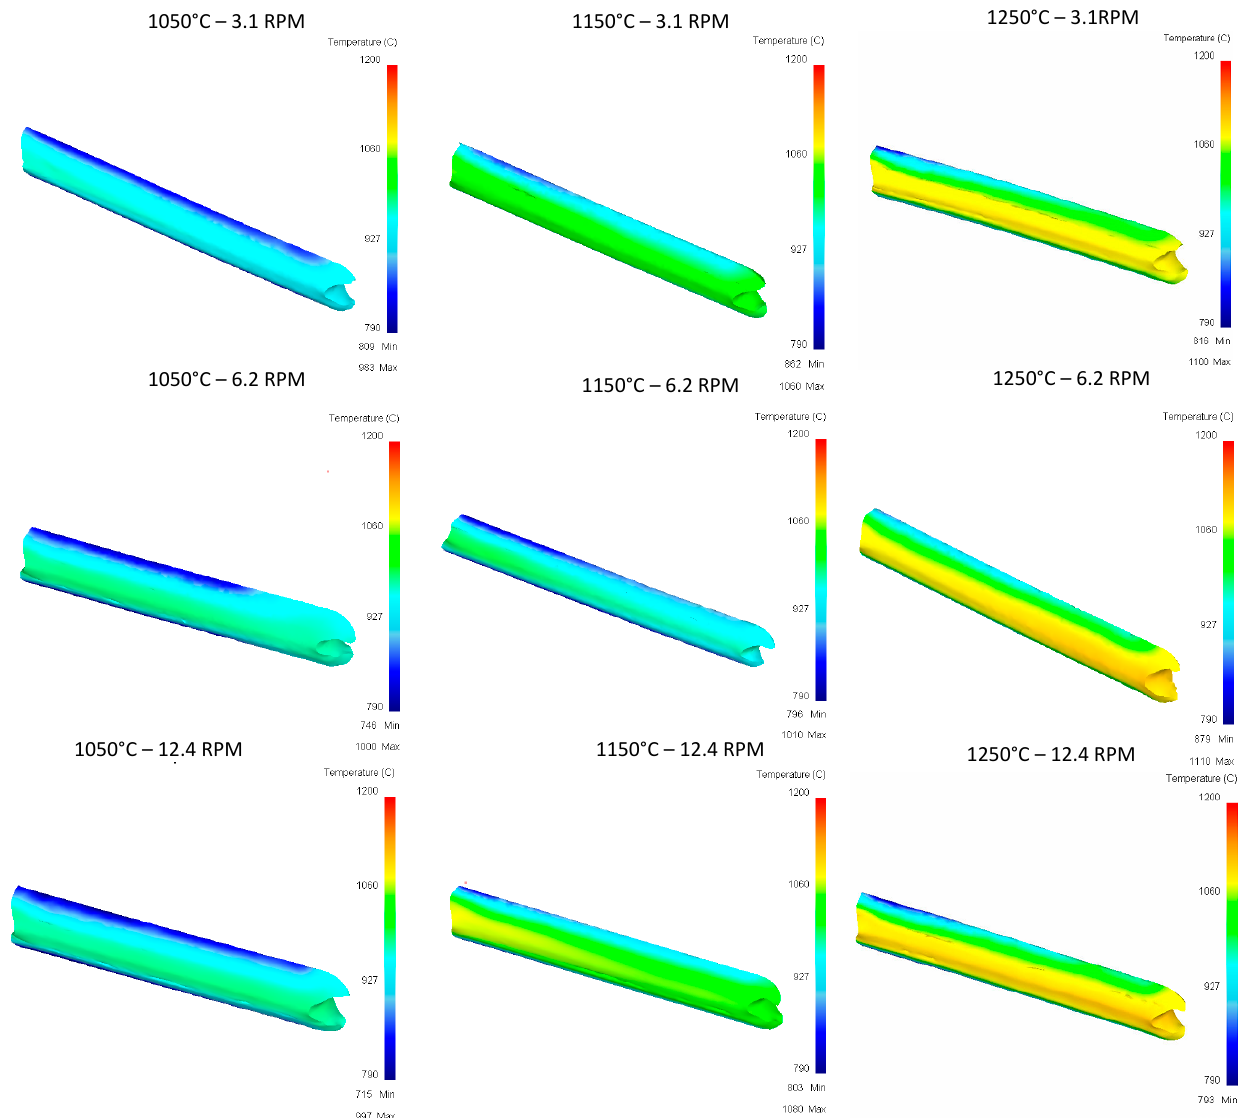
Figure 18. Upper Rail temperature graph for third pass.